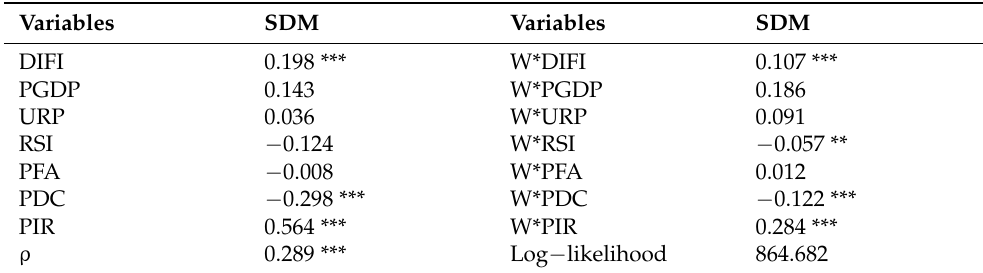
Table 8. The estimated results of SDM.